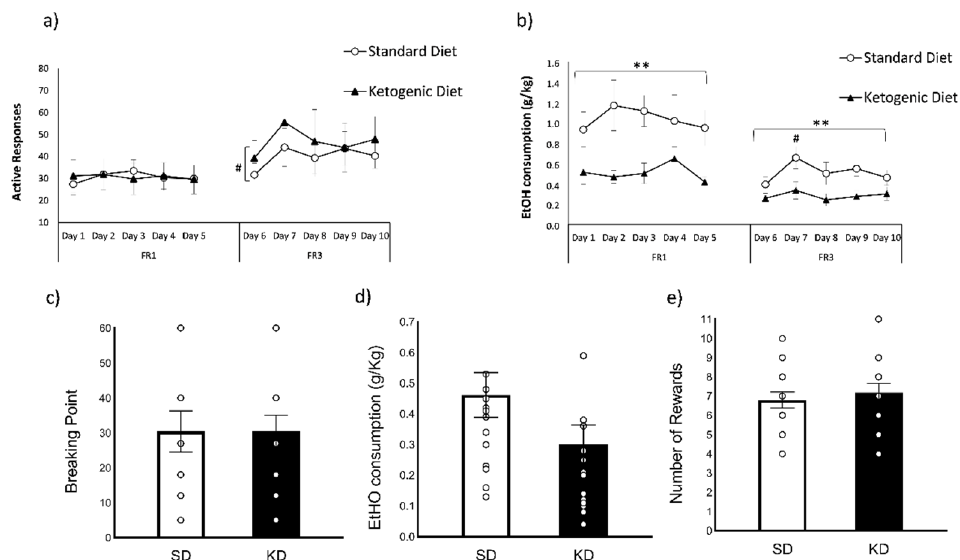
Figure 4. Oral EtOH self-administration (SD n = 15; KD n = 16). ( a ) The dots represent means and the vertical lines ± SEM of the amount of the number of active responses and ( b ) the volume of 6% EtOH consumption during FR1 and FR3 (in g/kg). ( c ) The columns represent means and the vertical lines ± SEM of breaking point values ( d ) the volume of 6% EtOH consumption (in g/kg) and ( e ) the number of rewards obtained during PR. ** p < 0.01, significant difference with respect to the SD group. # p < 0.05, significant differences with respect to Day 7.